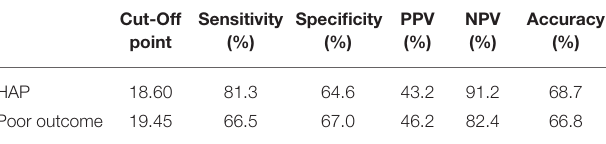
TABLE 4 | The cut-off points and accuracy of Hcy to predict HAP and poor